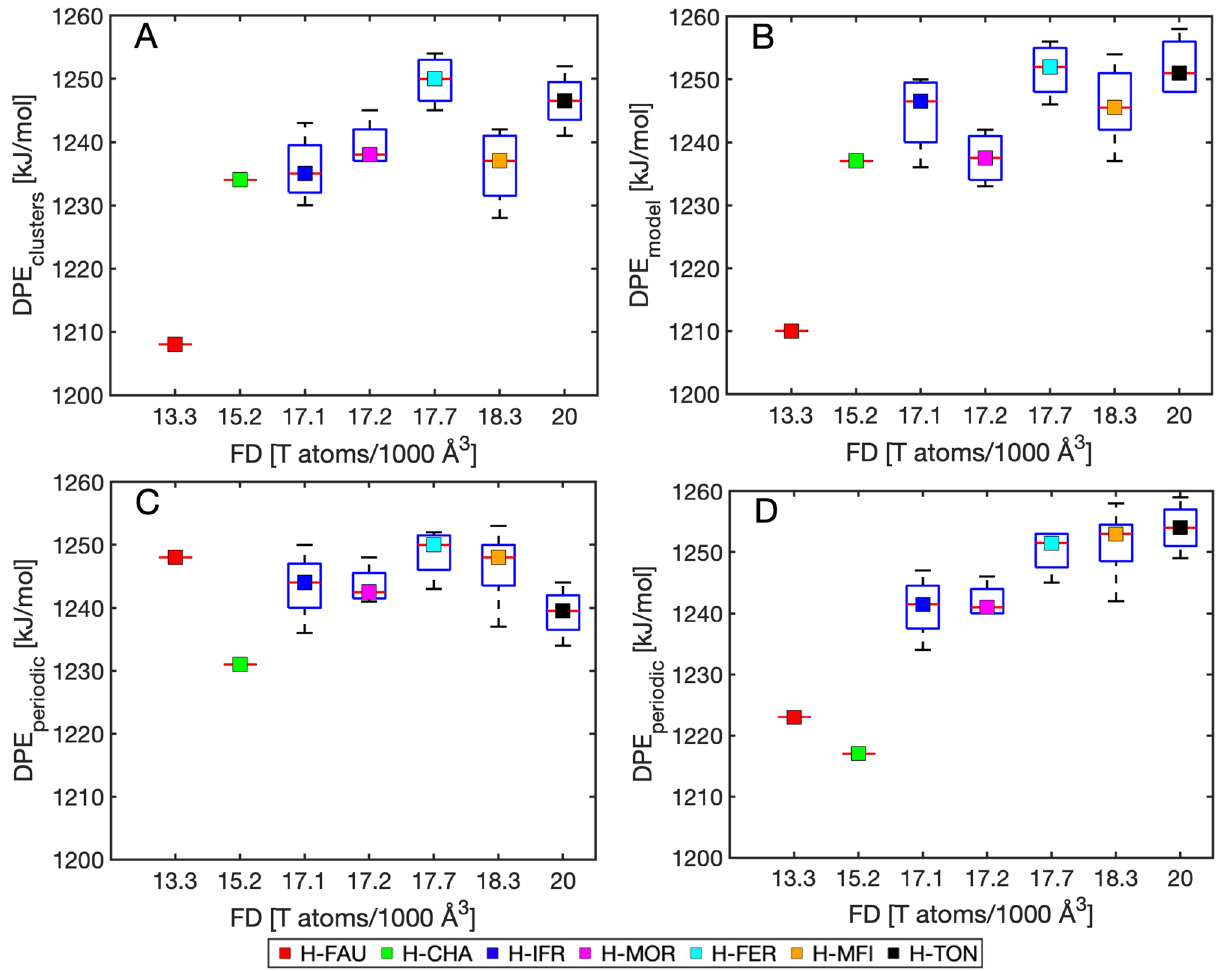
Figure 6. Deprotonation energies of investigated materials ( A ) DPE clusters , ( B ) DPE model , ( C ) DPE periodic with ∆ BC defined in Eq. 1 with vertical shift to yield the same mean as DPE model , and ( D ) DPE periodic with ∆BC taken as an error from DPE model as shown in Figure S5. The boxplots show statistical behavior within material